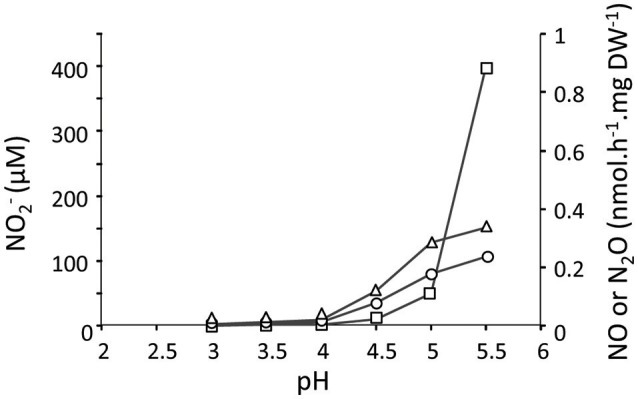
The concentration of NO2- (open rectangles) and production rates of NO (open triangles) and N2O (open circles) at pH values from 3 to 5.5 in the H2/NH4+ continuous culture (1.2 L; D = 0.023 h−1; OD600 = 0.85; O2 limited; 4 mM NH4+). The amounts of NO2-, NO and N2O were determined when cells in the reactor reached the steady state. Each data point represents the average of two replicates with deviation of individual values below 5%.